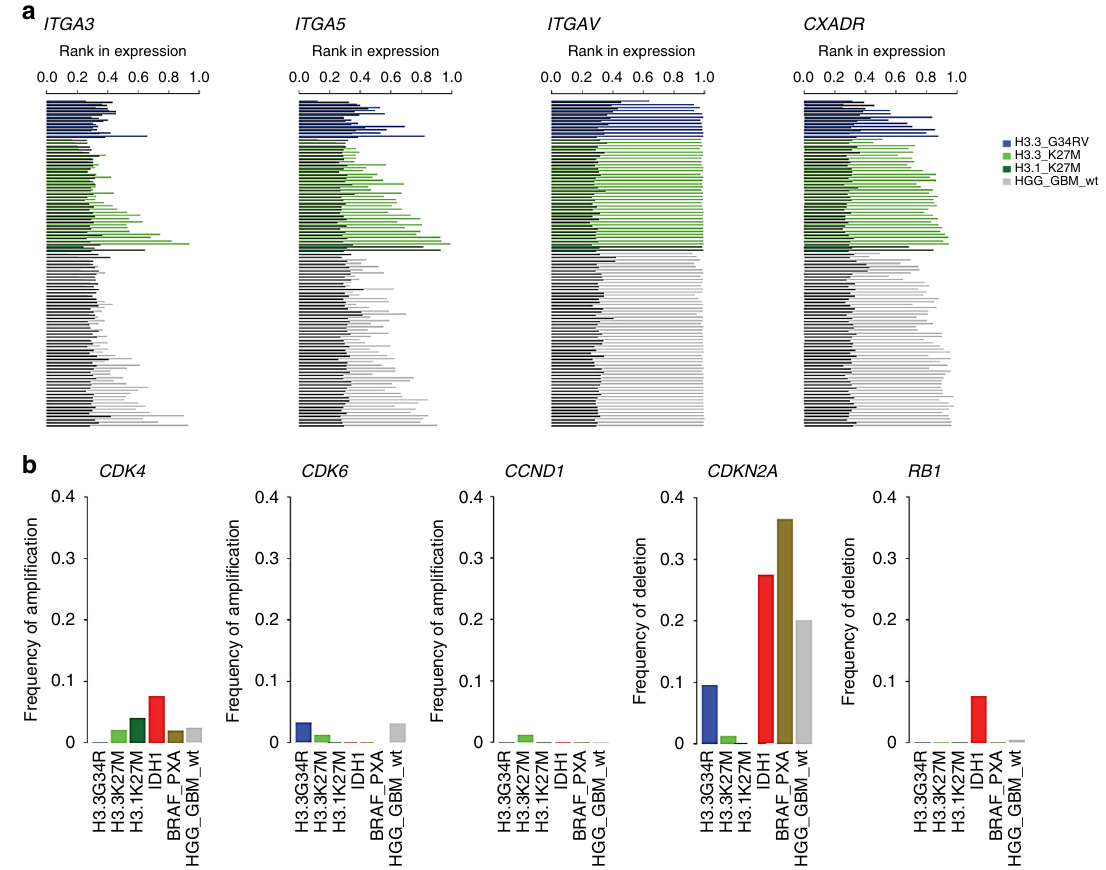
Fig. 1 Delta-24-RGD determinants of replication and infection in pHGG and DIPG. a Assessment of integrin and CAR expression in pHGG and DIPGs. b Characterization of ampli fi cations and deletions of RB pathway genes in pHGG and DIPGs. Source data are provided as a Source Data fi le